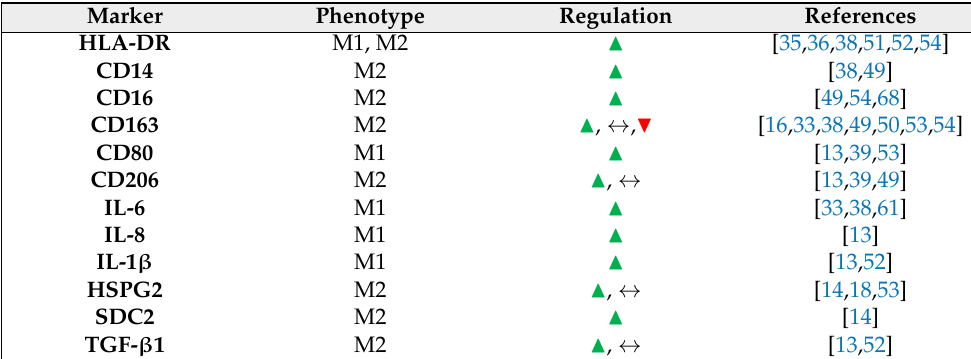
Table A1. Literature-based analysis of the protein markers used for the phenotypic characterization of the M Φ subtypes generated in this study. All of the studies cited were derived from human M Φ polarized toward an M1- or M2-like phenotype using different stimuli. The column “phenotype” describes the marker expression in the M1- or M2-like M Φ subtype, compared to each other. The column “regulation” gives the marker expression changes with respect to the M Φ phenotype indi- cated. Expression increases were indicated by the symbol “ (cid:78) ,” decreases by the symbol “ (cid:72) ,” and no significant changes with “ ↔